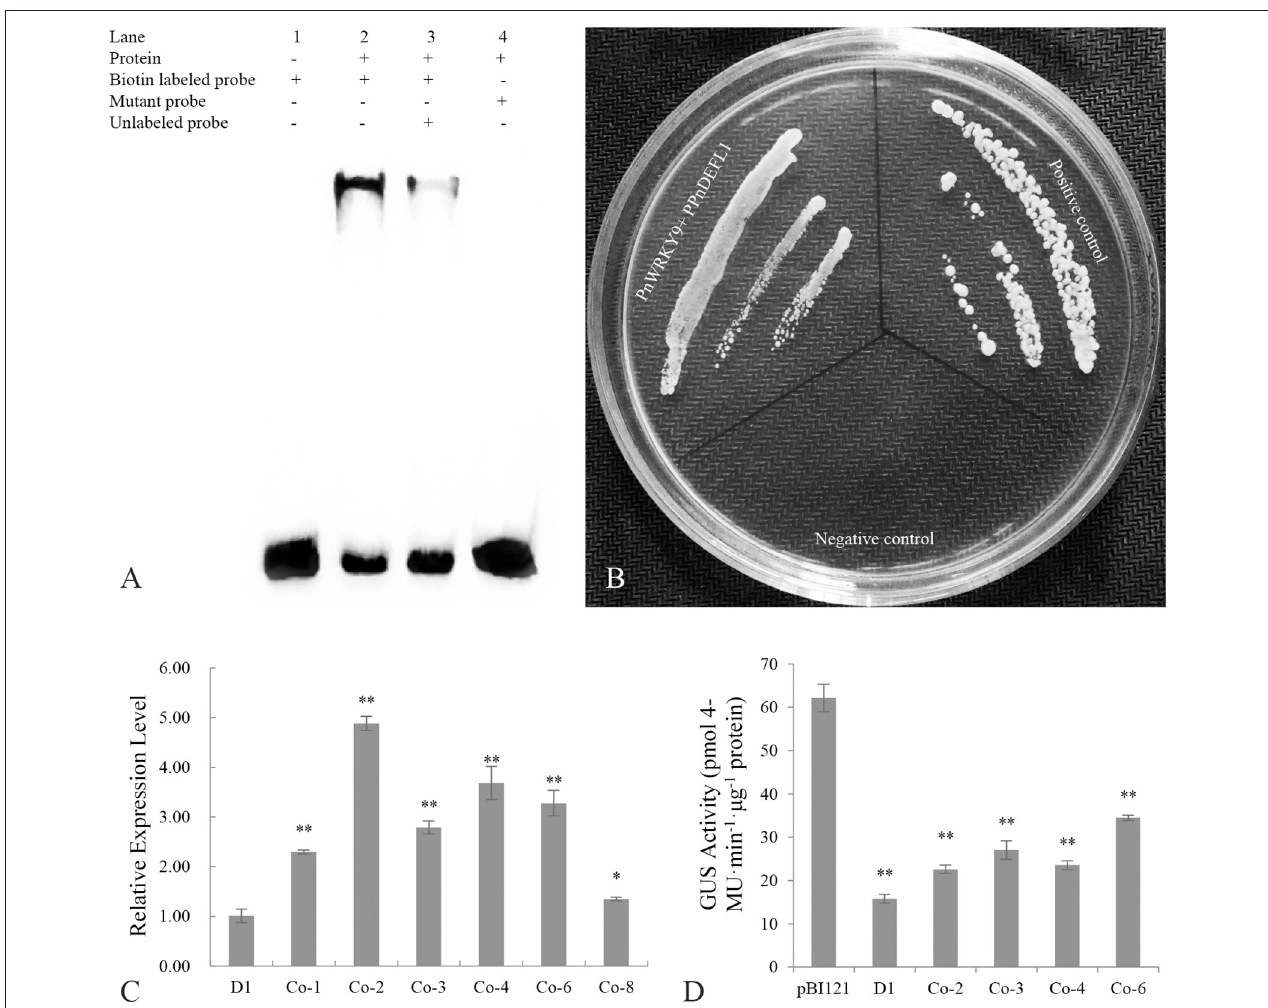
FIGURE 8 | Transcriptional regulation of PnWRKY9 on PPnDEFL1. (A) EMSA assay verified the specific binding of PnWRKY9 with PPnDEFL1. Lane 1, the biotin labeled free probes containing the W-box sequence of PPnDEFL1; Lane 2, PnWRKY9 can interact with biotin labeled probes containing W-box sequence of PPnDEFL1; Lane 3, PnWRKY9 showed the interaction with the unlabeled probes and biotin labeled probes containing W-box sequence of PPnDEFL1; Lane 4, PnWRKY9 cannot interact with the mutant probes labeled by biotin. (B) Y1H assay verified the transcriptional activation of PnWRKY9 on PPnDEFL1. PnWRKY9 + PPnDEFL1, pGADT7- PnWRKY9 and PPnDEFL1-pAbAi co-transformed yeast cells; Positive control, p53-pAbAi and pGADT7- p53 co-transformed yeast cells; Negative control, PPnDEFL1-pAbAi and pGADT7- P53 co-transformed yeast cells. (C) Analysis of GUS gene expression level in PPnDEFL1- GUS / PnWRKY9 co-expression tobacco (Co-1/2/3/4/6/8). The transgenic tobacco (D1) just expressing the PPnDEFL1- GUS was control. (D) Determination of GUS activity in PPnDEFL1- GUS / PnWRKY9 co-expression tobacco (Co-2/3/4/6). The transgenic tobacco just expressing the PPnDEFL1- GUS (D1) and pBI121- GUS were control (* p < 0.05; ** p <